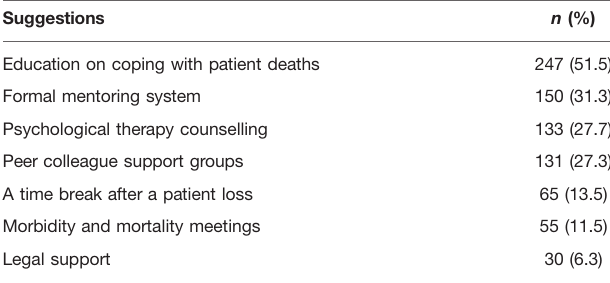
TABLE 4 | Suggestions of the general surgeons for coping with patient losses or adverse